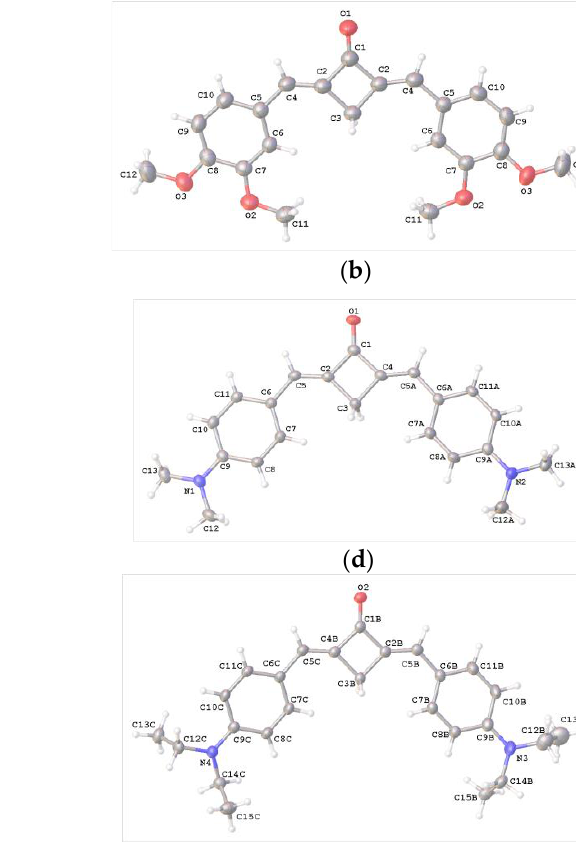
Figure 2. Molecular structure and atom numbering in crystals 1b ( a ), 1c ( b ), 1d ( c ), 1e ( d ) and two independent units 1f ( e and f ).